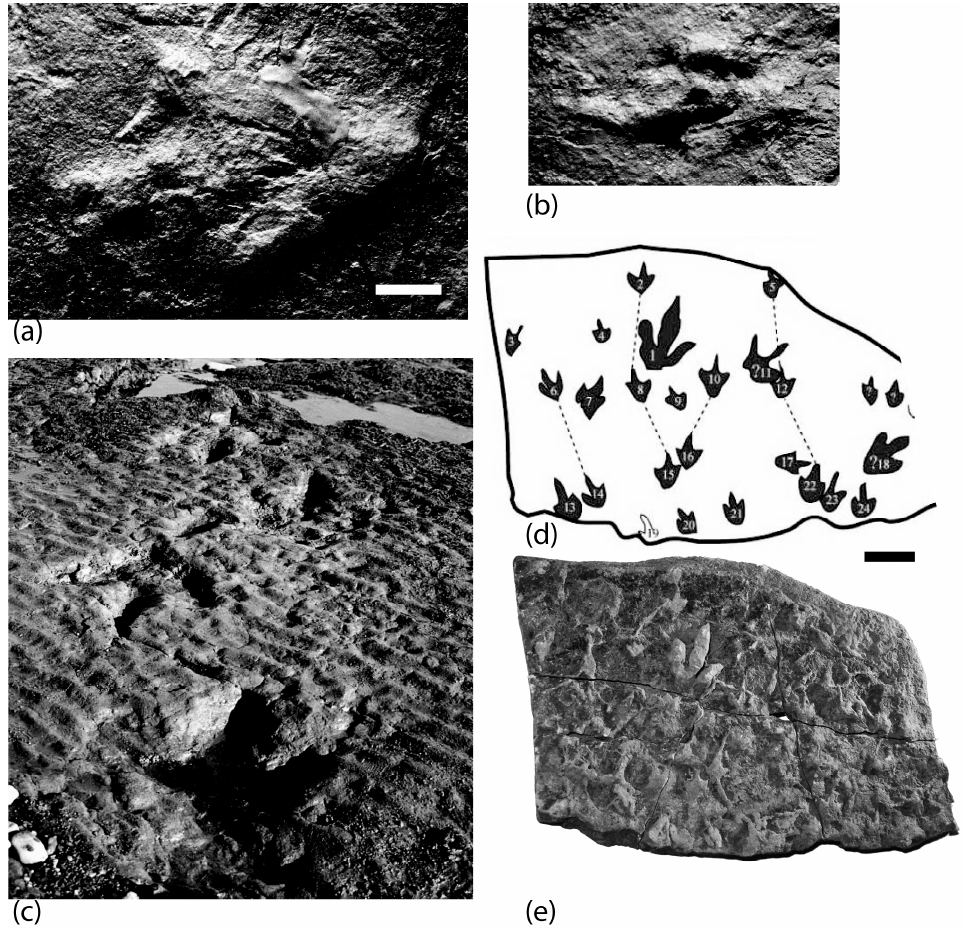
Figure 5. Examples of theropod footprints from the Trotternish Peninsula, Isle of Skye, ( a ) Eubrontes -like footprint and; ( b ) Grallator -like footprint from the Valtos Formation at Rubha nam Brathairean (GLAHM 101273); ( c ) large in situ footprints from the the Duntulm Formation at An Corran near Staffin (cast in the Hunterian (GLAHM 114806); footprint in foreground is 53 cm long); ( d ) diagram and ( e ) photograph of slab with many smaller theropod footprints from the Kilmaluag Formation in Score Bay west of Duntulm Castle. Scale for ( a ) and ( b ) = 5 cm; scale for ( d ) and ( e ) = 20 cm.